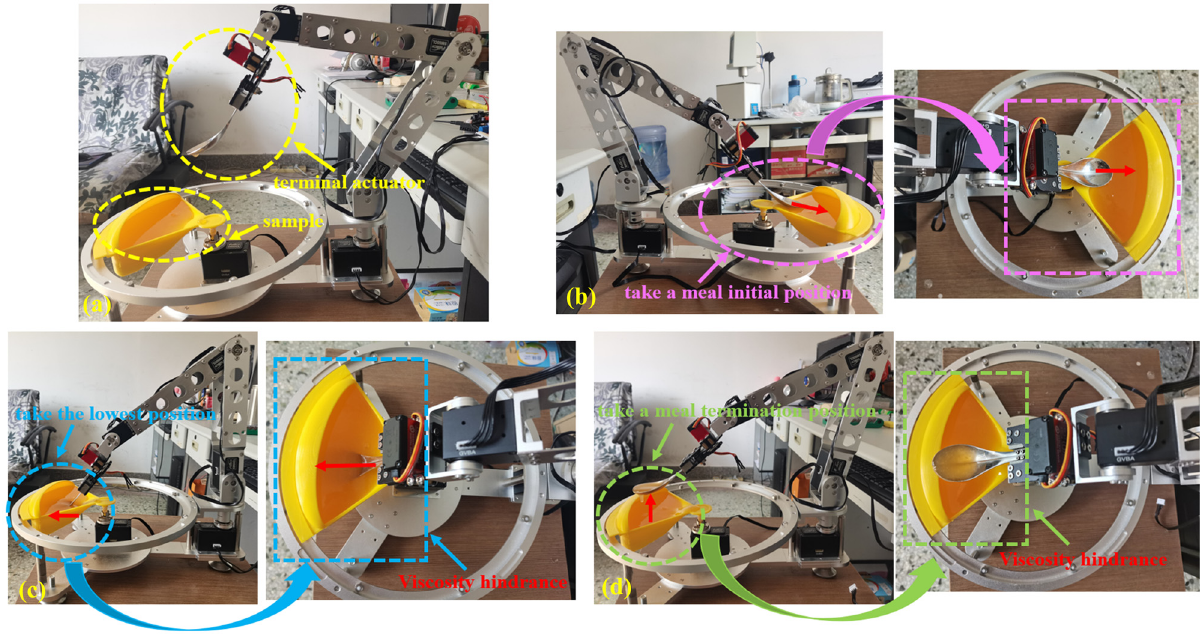
Figure 1: In fl uence of viscosity on spoon fi lling rate when serving sticky meals: ( a ) initial state, ( b ) just touching the sticky meal, ( c ) serving sticky meal, and ( d ) leaving the plate after